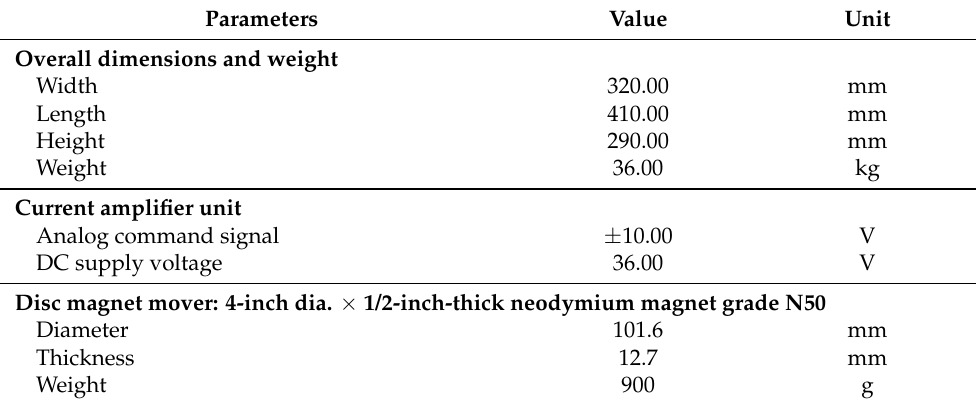
Figure 7. Permanent magnet mover with reflective markers: ( left ) top view; ( right ) bottom view. Table 4. Compact planar maglev system